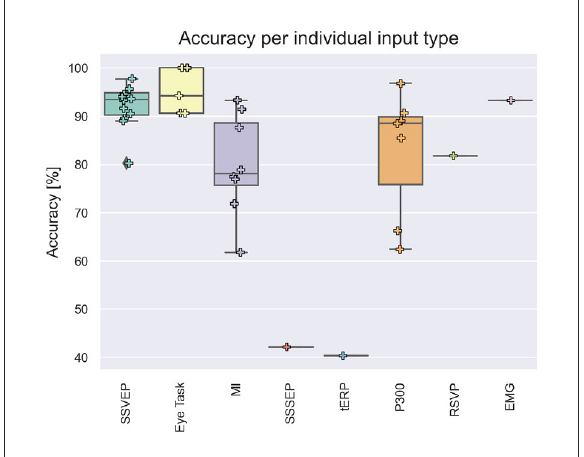
FIGURE9 Accuracy per individual input type during online trials.